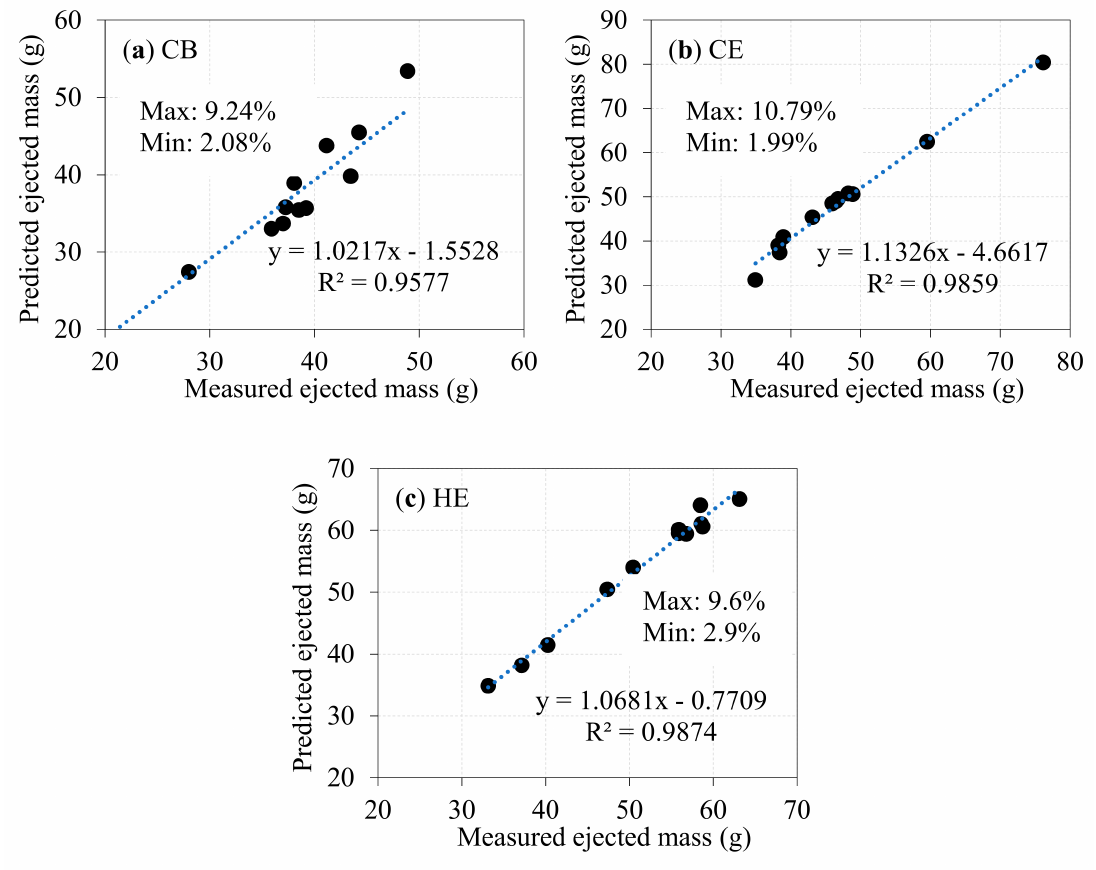
Figure 21. Comparison of mass expelled from the top surface of targets subjected to CB projectile; experimental versus predicted